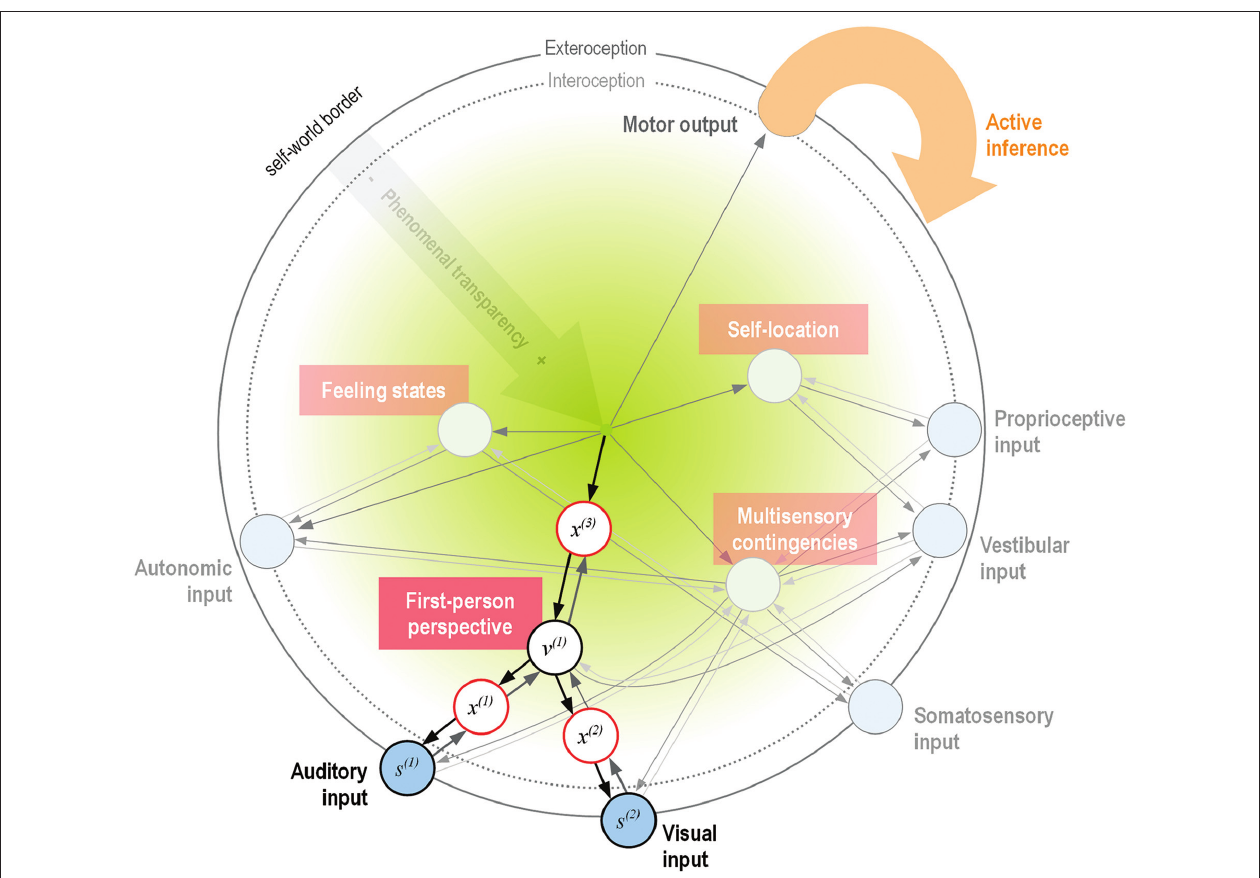
FIGURE 1 | Schematic proposal for a mapping of the phenomenal self-model onto a hierarchical generative model (format adapted from Bastos et al., 2012). Shown here is only the system’s model of itself, where representational nodes at each level generate descending predictions to increasingly specialized lower levels (symbolized by darker arrows). In this special case, the single modeled cause of sensations is the minimal phenomenal self (Metzinger, 2004a), which generates predictions about the state of one or many sensory modalities (blue circles). The inversion of this generative model (a predictive coding scheme, lighter arrows) infers hidden causes—and thus ultimately, the self as the single cause—of sensory input via minimization of prediction error (Friston, 2011). For simplicity, only one intermediate level of nodes within the hierarchy is displayed, consisting of the basic properties of minimal selfhood as reviewed (white circles). As a (simplified) illustration of the hierarchical generative processing, the case of the 1PP is highlighted. Here, descending predictions of the unified self-model (black arrows) generate sensory data s ( i ) in the respective modalities (auditory and visual). This happens via a hierarchy of hidden states x ( i ) and hidden